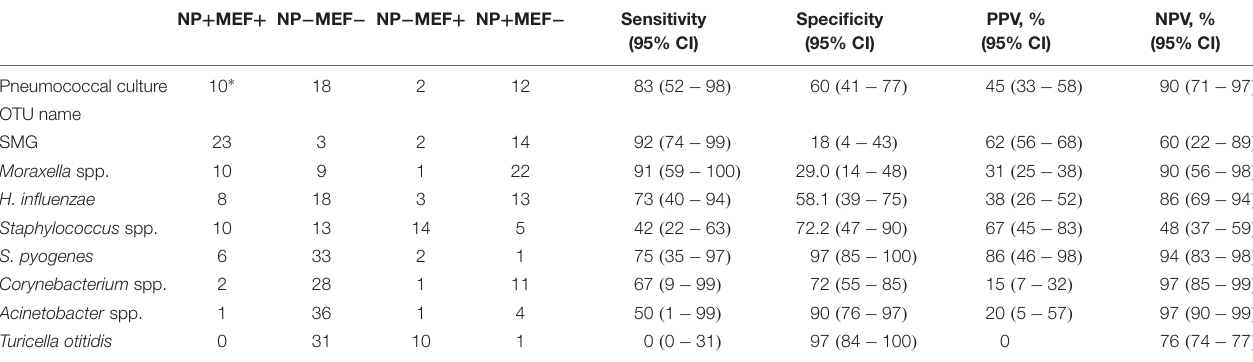
TABLE 2 | Sensitivity and specificity MEF/NP based on pneumococcal culture and presence and absence of the eight most frequent OTUs in the NPS and ears,